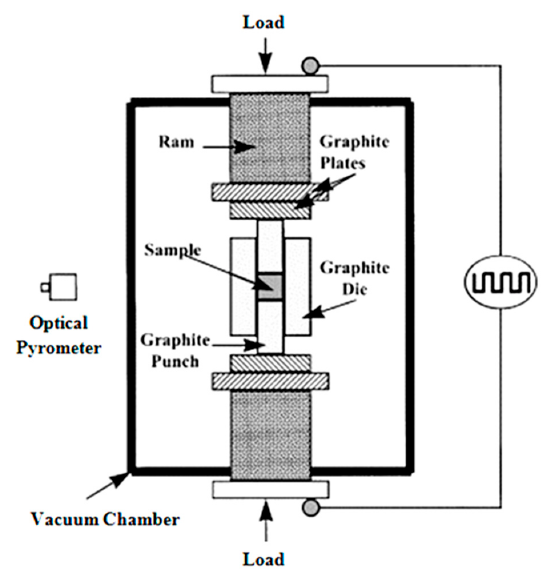
Figure 4. Schematic of spark plasma sintering [146] (Copyright Elsevier, 2000, Journal of the European Ceramic Society).